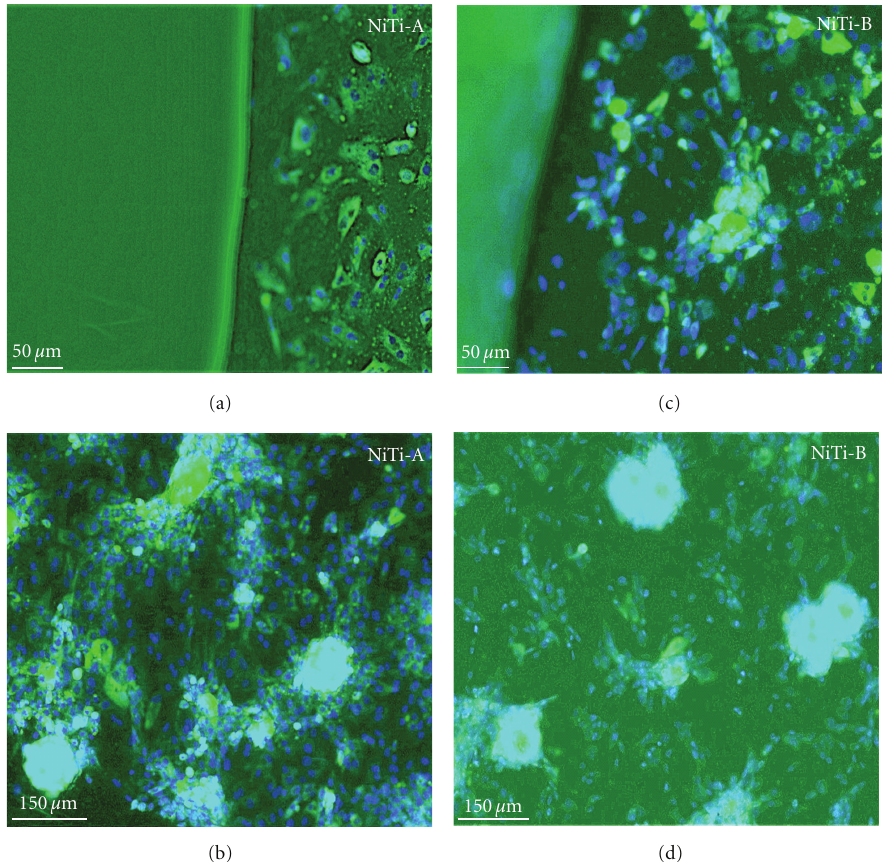
Figure 13: Fluorescence microscopy of MSCs transfected with a eGFP-N1 plasmid DNA on the NiTi-A and NiTi-B surfaces. Nuclei are stained with DAPI; 77th day of cultivation; magnification is × 20 (a), (b) and × 10 (c), (d).